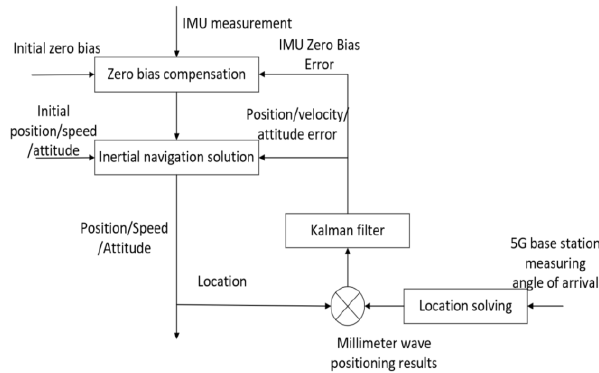
Figure 7 . Structure diagram of IMU/5G millimeter wave integrated positioning